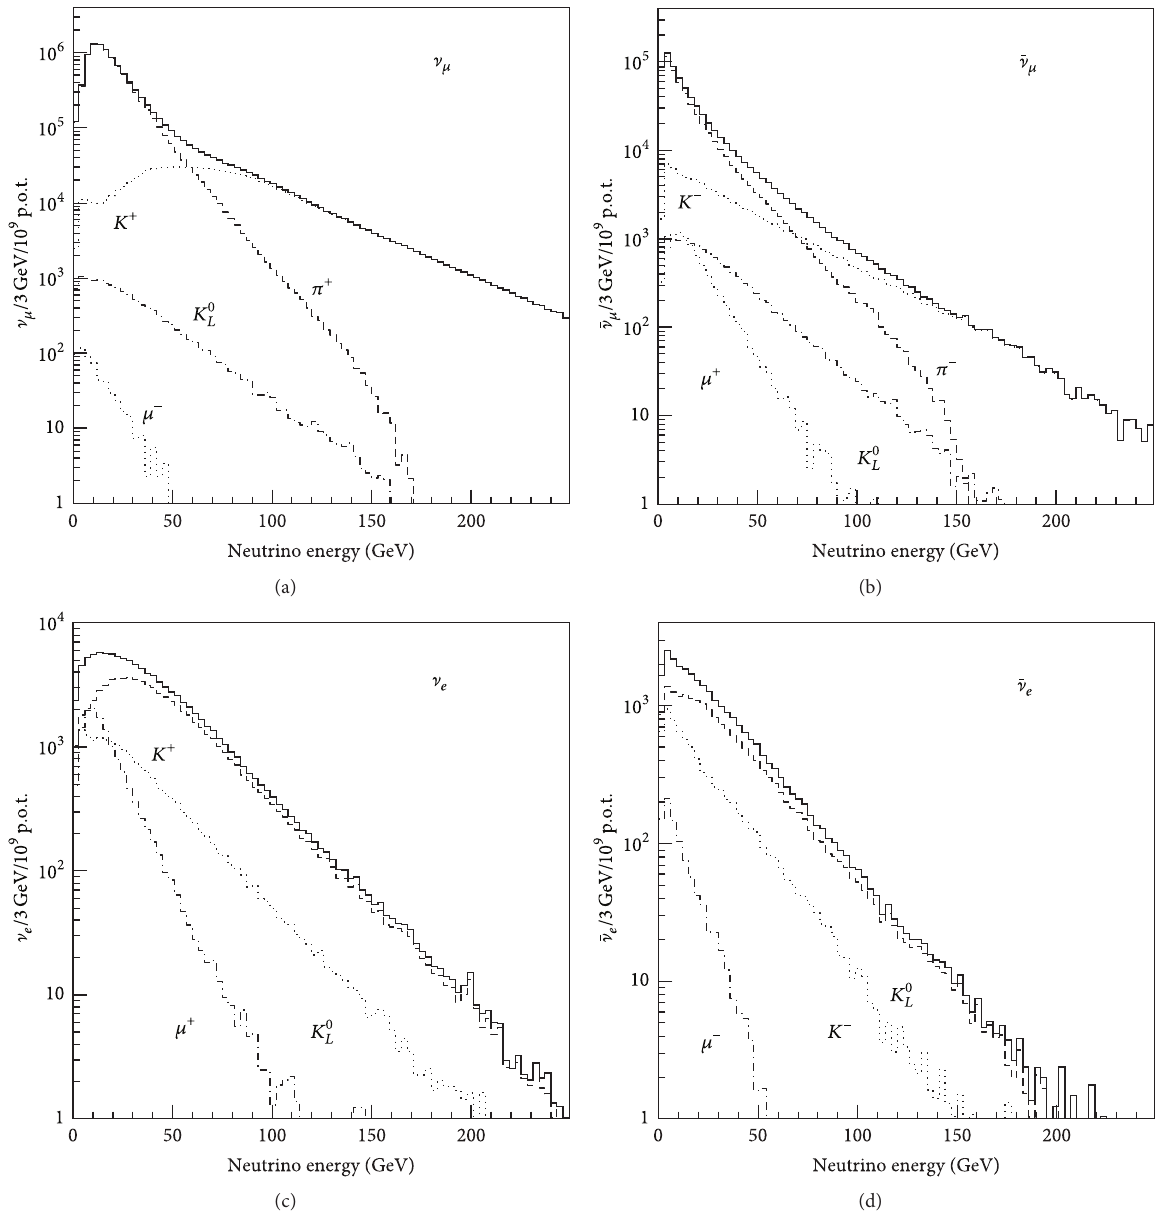
Figure 1: Fluxes of the various neutrino species in the NOMAD detector for 10 9 protons on target (from